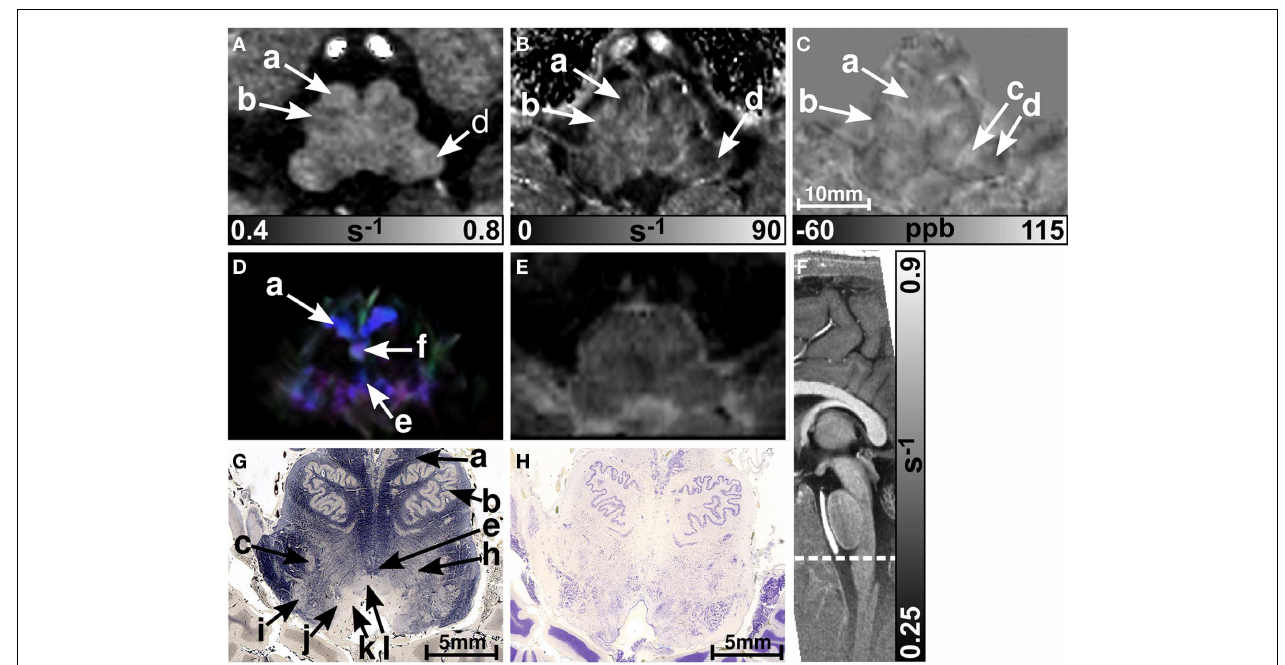
FIGURE 5 | Images of the rostral part of the medulla oblongata . R 1 , R ∗ , and susceptibility maps as well as direction-encoded track-density 2 (same color-encoding as in Figure 1 ; slightly distorted compared to the other axial image contrasts) and T 2 -weighted images of the same region are presented in axial orientation from (A–E) , respectively.The sectional plane of the axial images is indicated by the dashed line overlaid on the sagittal R 1 map shown in (F) . Axial histological sections from a different subject stained for myelin and cells are illustrated in